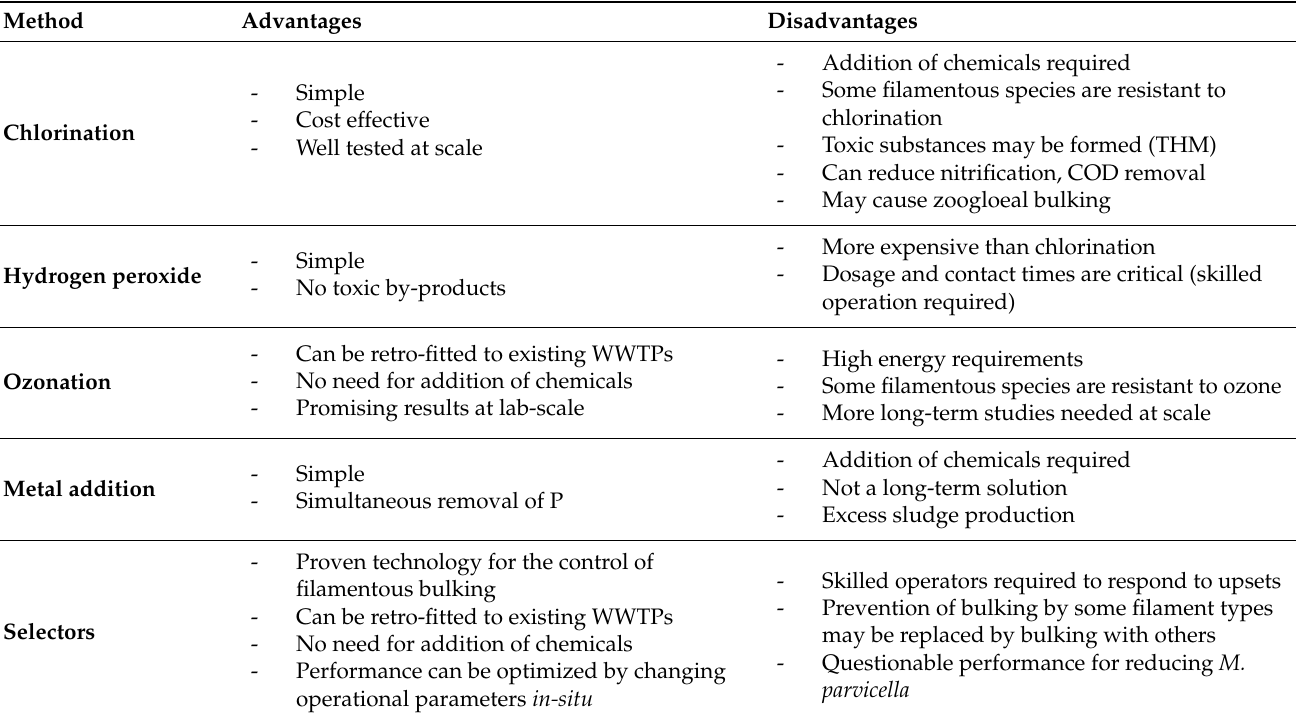
Table 2. Advantages/disadvantages of some methods used to control filamentous